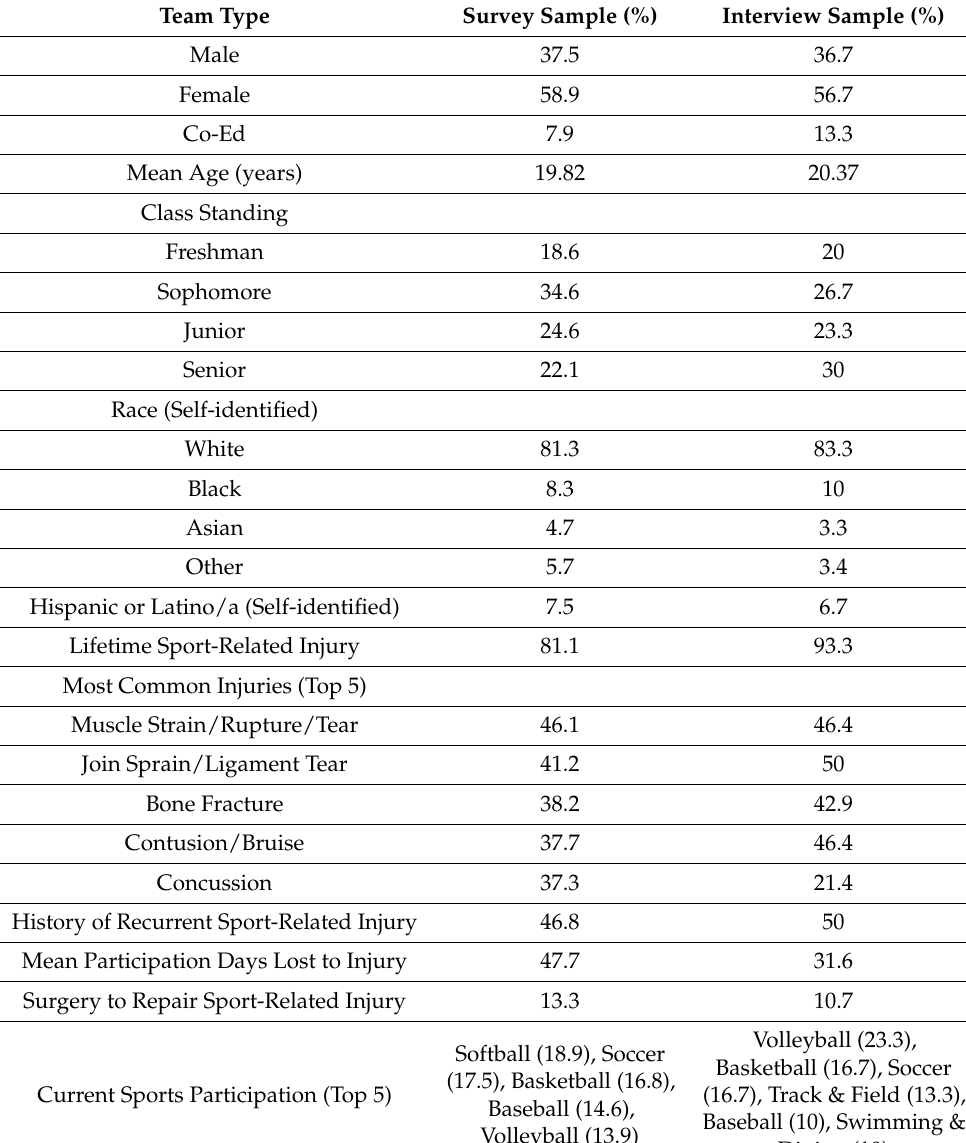
Table 1. Full Sample